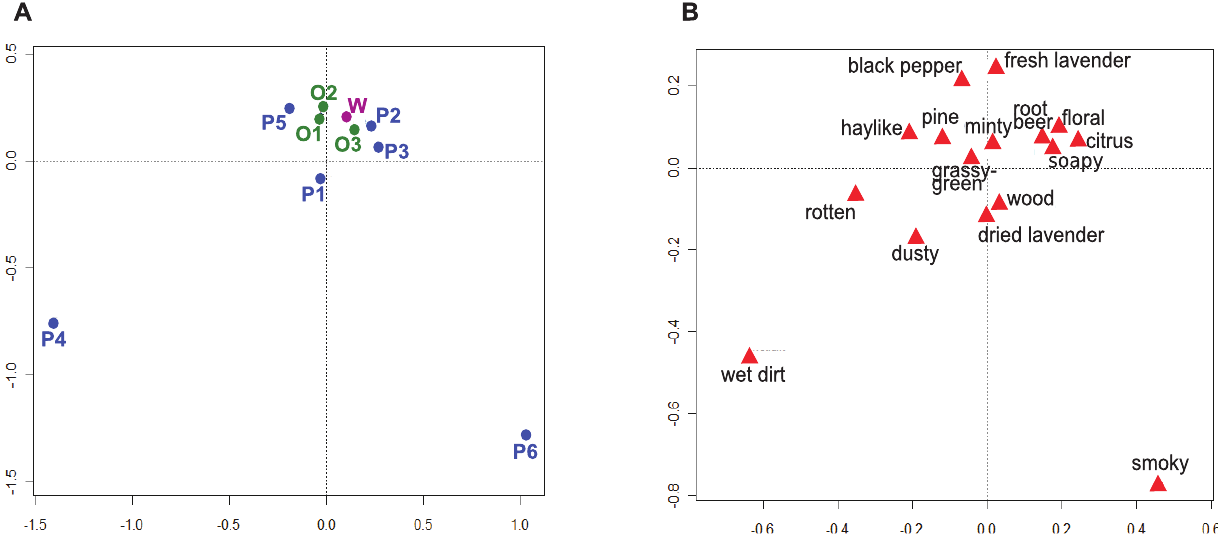
Figure 4. Correspondence Analysis of (A) lavender volatile mixtures; and (B) lavender volatile mixture descriptors. Abbreviations for mixtures correspond to those in Table 1. Terms generated by the panelists to describe the perceived odor of from each Experimental Condition described in Table 1 were tabulated by frequency of use and used for the Correspondence Analysis. 30.57% of variance explained by dimension 1 (x), 22.84% of variance explained by dimension 2 (y).